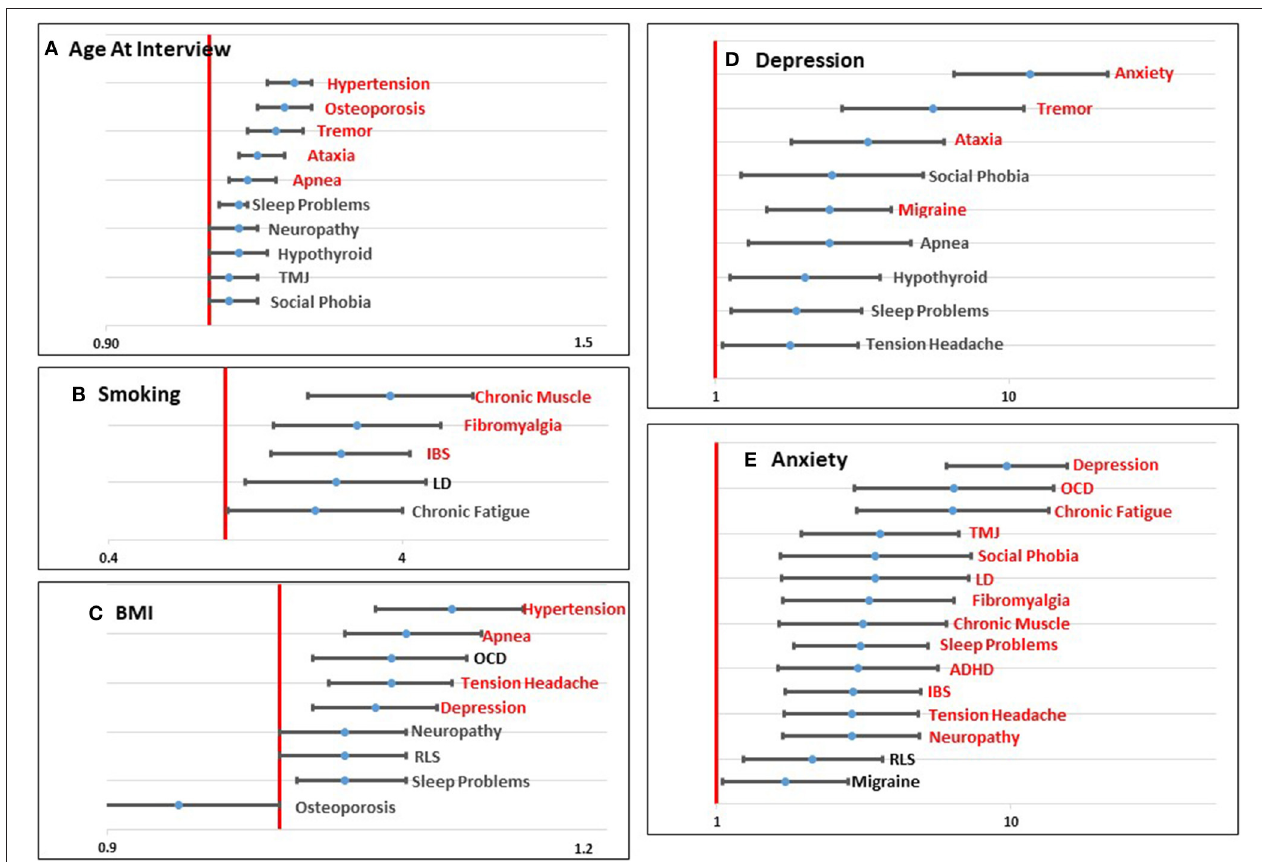
FIGURE 1 | Graphical representation of significant ( p < 0.0023; shown in red) and marginally significant ( p < 0.05; shown in black) odds ratios for age at interview (A) , smoking (B) , BMI (C) , Depression (D) , and Anxiety (E) for each comorbid condition tested. Values to the left of the red line (1.0) indicate a decreased risk associated with the predictor variable and the comorbid condition. Values to the right of the red line indicate an increased risk associated with the predictor variable and the comorbid condition.